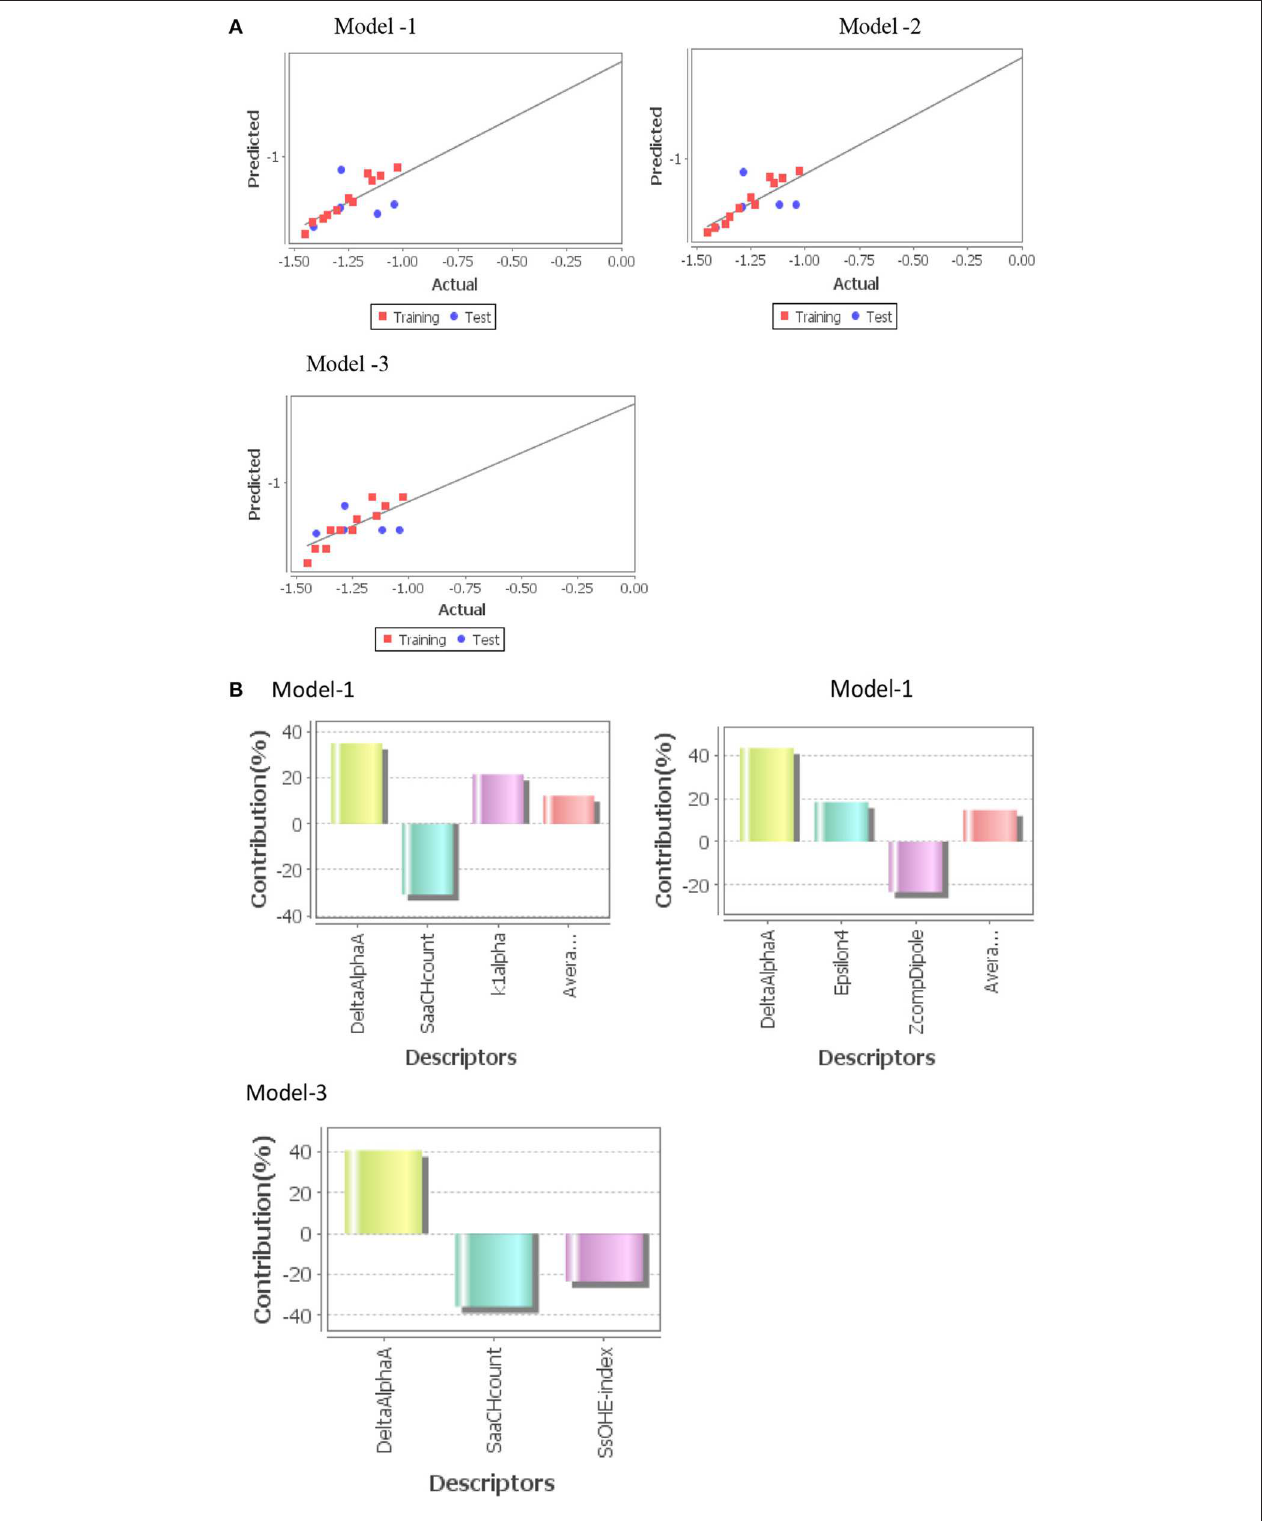
FIGURE 6 | (A) Graphs of experimental vs. predicted nematicidal activity of different models against M. incognita. (B) Contribution charts of 2D-QSAR models.